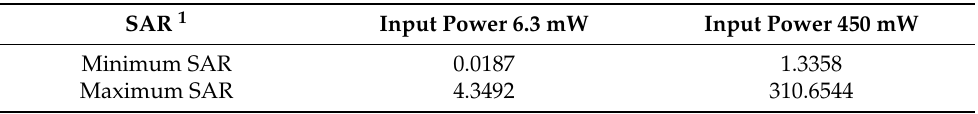
Table 4. Comparison of the maximum and minimum SAR values at two input powers of the wearable antenna, at 2.41